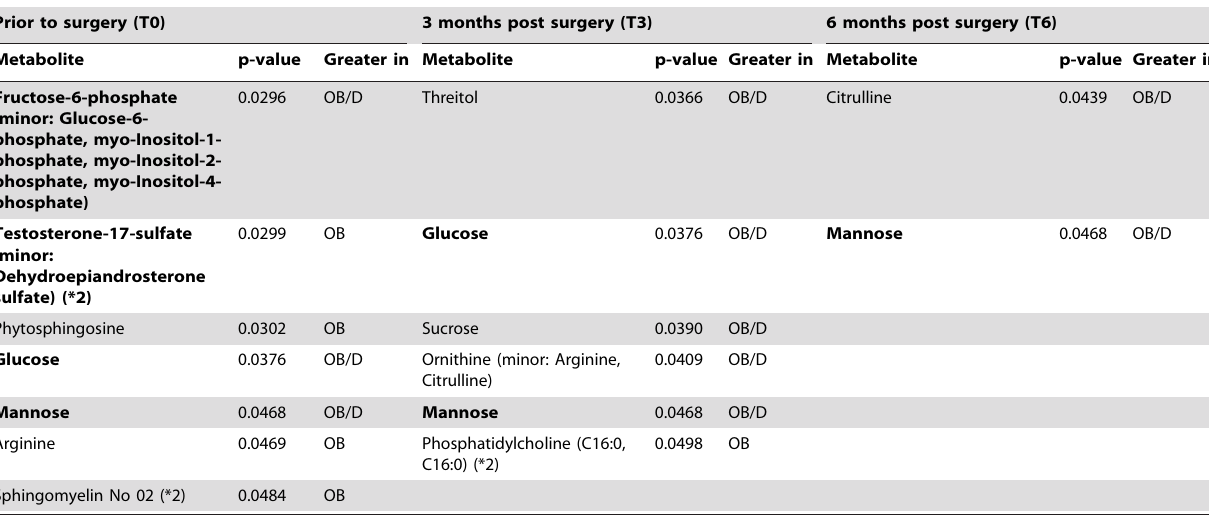
FIGURE 1 ): asparagine, lysophosphatidylcholine (C18:2), nervo- nic (C24:1) acid, p-Cresol sulfate, lactate, lycopene, glucose, and mannose. Lycopene, lysophosphatidylcholine, and nervonic acid serum levels were higher in OB subjects, while asparagine, p-